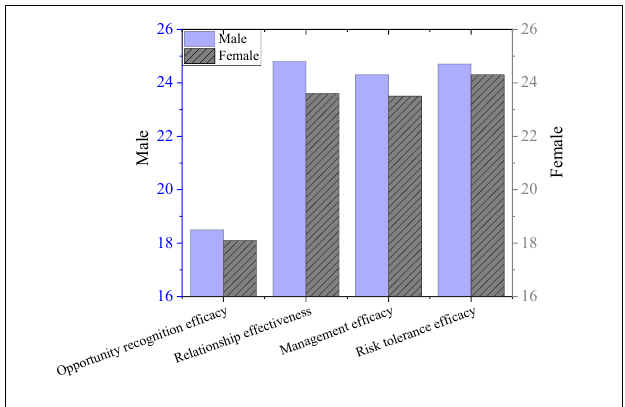
FIGURE 7 | The self-efficacy comparison results.